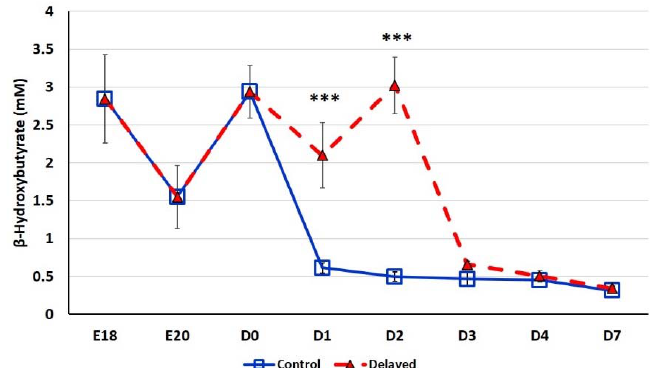
Figure 5. Plasma β‐ hydroxybutyrate levels (mM) of fed from hatch and delayed fed broiler chicks. Mean (n = 6 males/treatment) plasma β‐ hydroxybutyrate levels. β‐ hydroxybutyrate was measured using a β‐ hydroxybutyrate (ketone body) colorimetric assay kit (Cayman Chemical). Error bars denote standard deviations. Significant ( p < 0.05) differences between treatment groups were determined using analysis of variance. *** p < 0.0001 denotes a significant difference between fed at